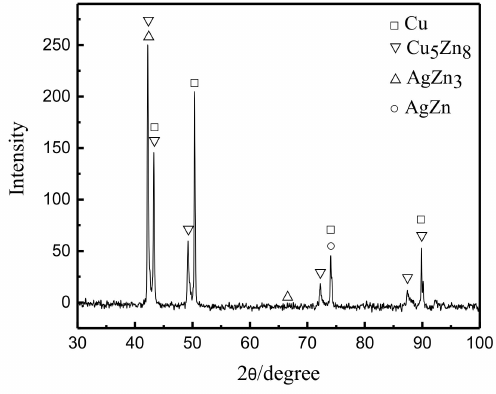
Figure 9. X-ray di ff raction analysis of the weld zone. (12,000 rpm, 280 mm /